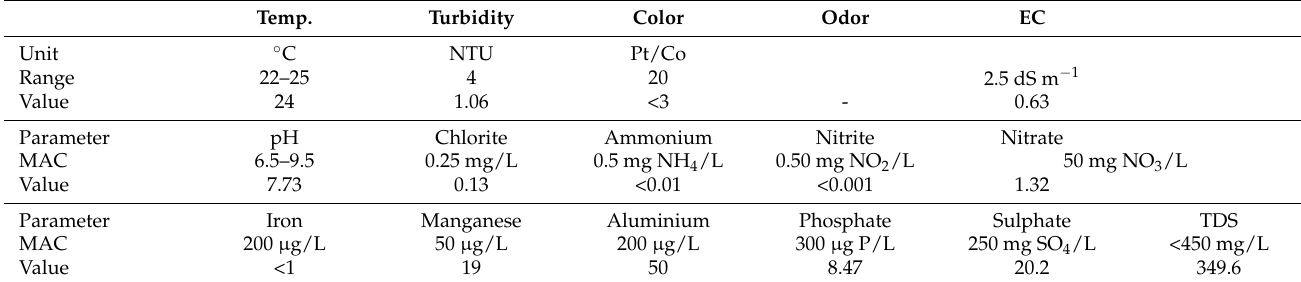
Table 1. Indicator and chemical parameters of irrigation